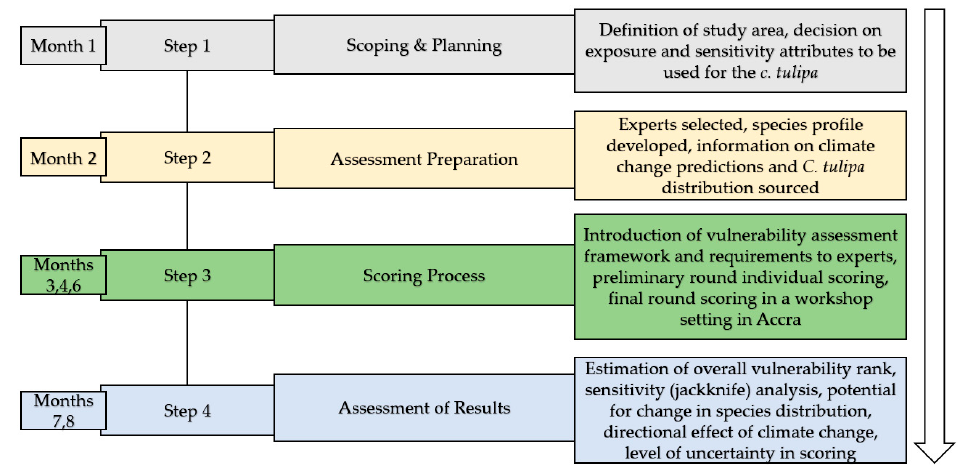
Figure 1. Summary of the four-step vulnerability assessment framework used in the